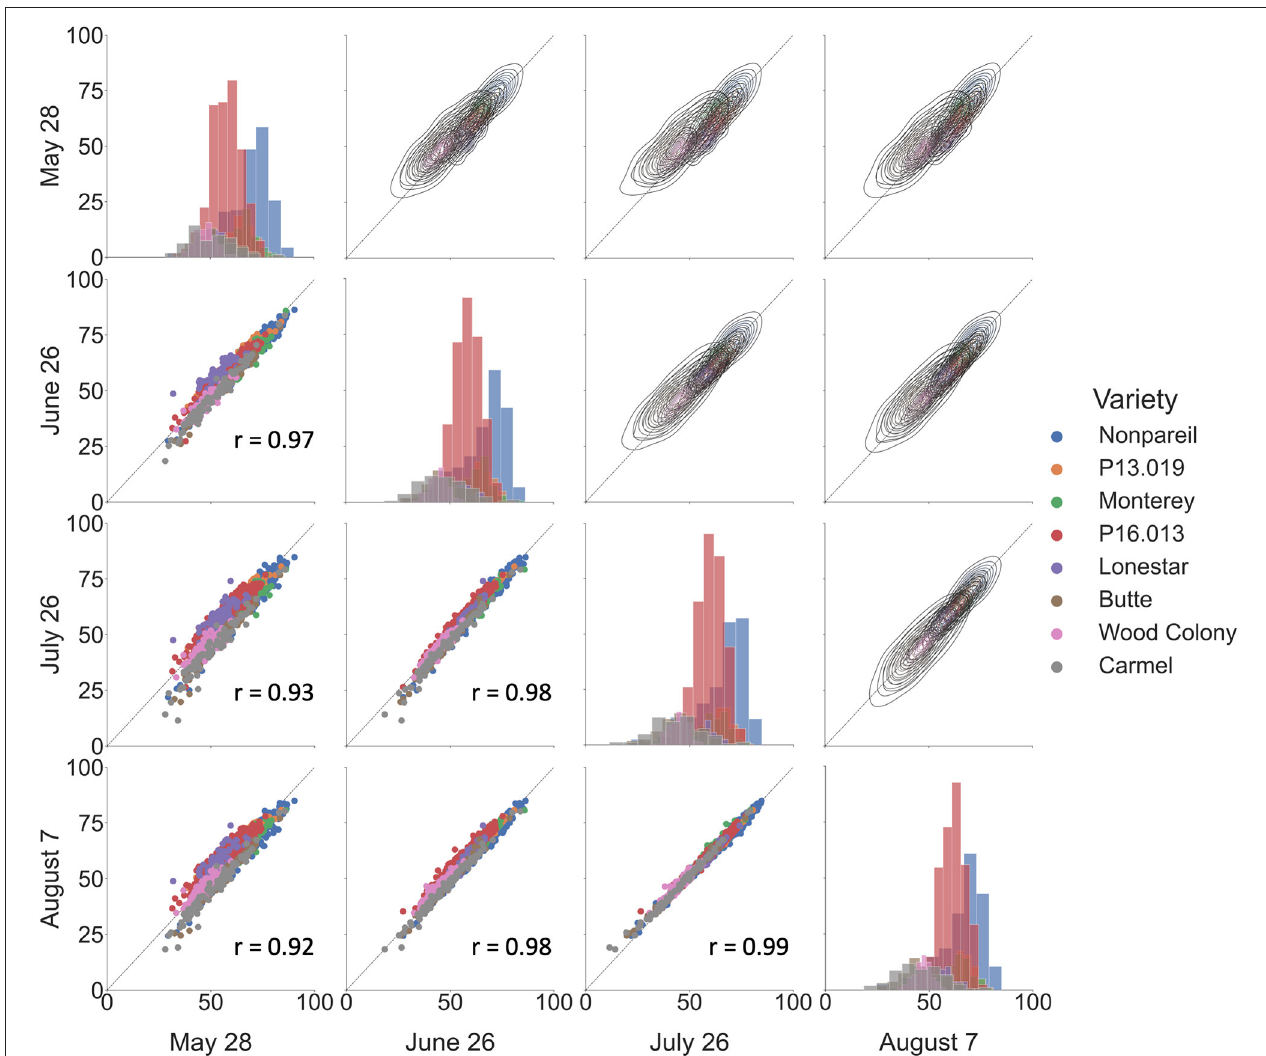
FIGURE 5 | Correlations of Virtual Orchard (VO) estimated canopy fractional PAR (fPAR) over the growing season in 2019. Scatter plots are shown in the lower-left half, kernel–density–estimate plots are shown in the upper right half, and histograms are shown on the diagonal. The black dotted line indicates the 1:1 line. r refers to Pearson’s correlation